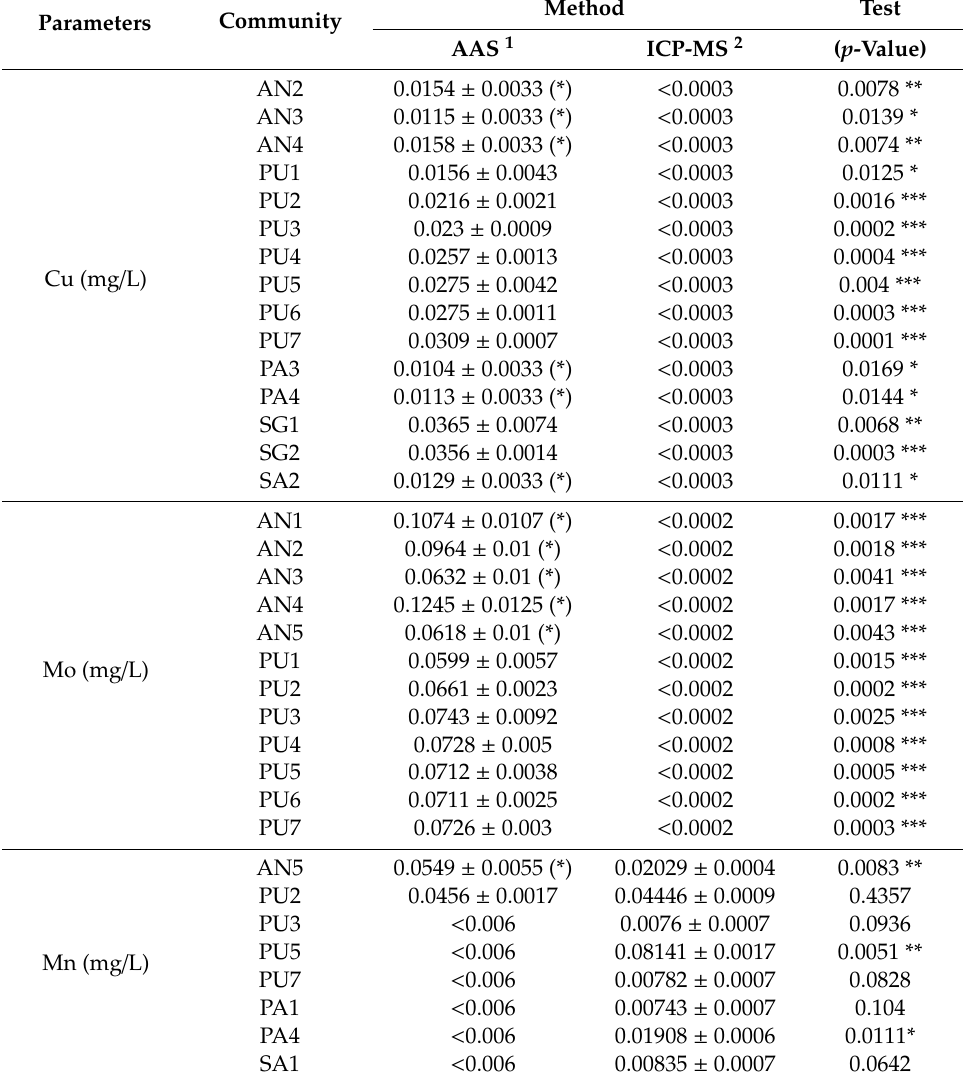
Table 6. Comparison of di ff erent analysis techniques for Cu, Mo, and